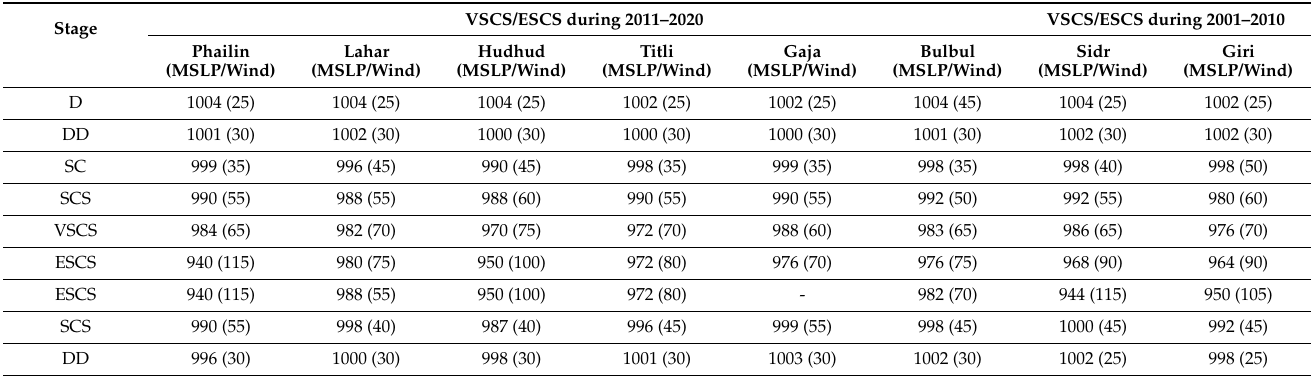
Table 7. Different stages of tropical cyclones’ mean sea level pressure (hPa) and maximum sustainable wind (knot) from October–November, during the 2011 to 2020 and 2001 to 2010 decades over the Bay of